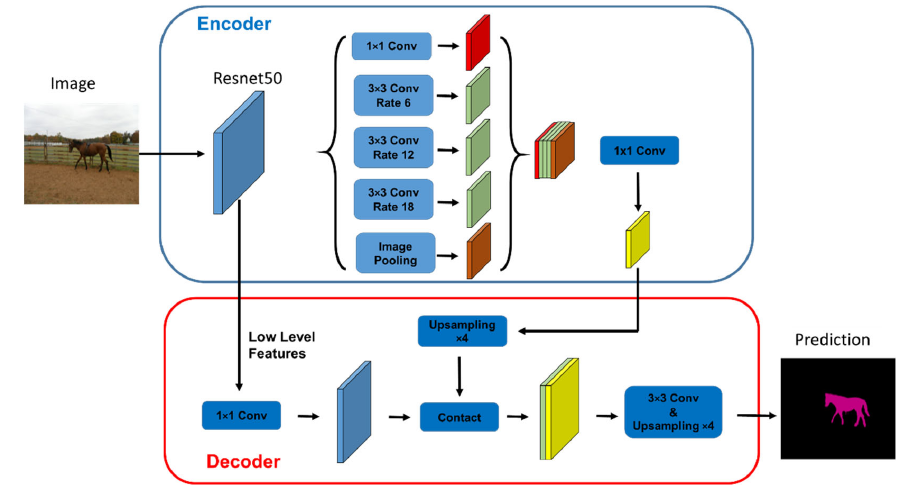
Figure 3. The network structure combining Deeplabv3 and ResNet 50.